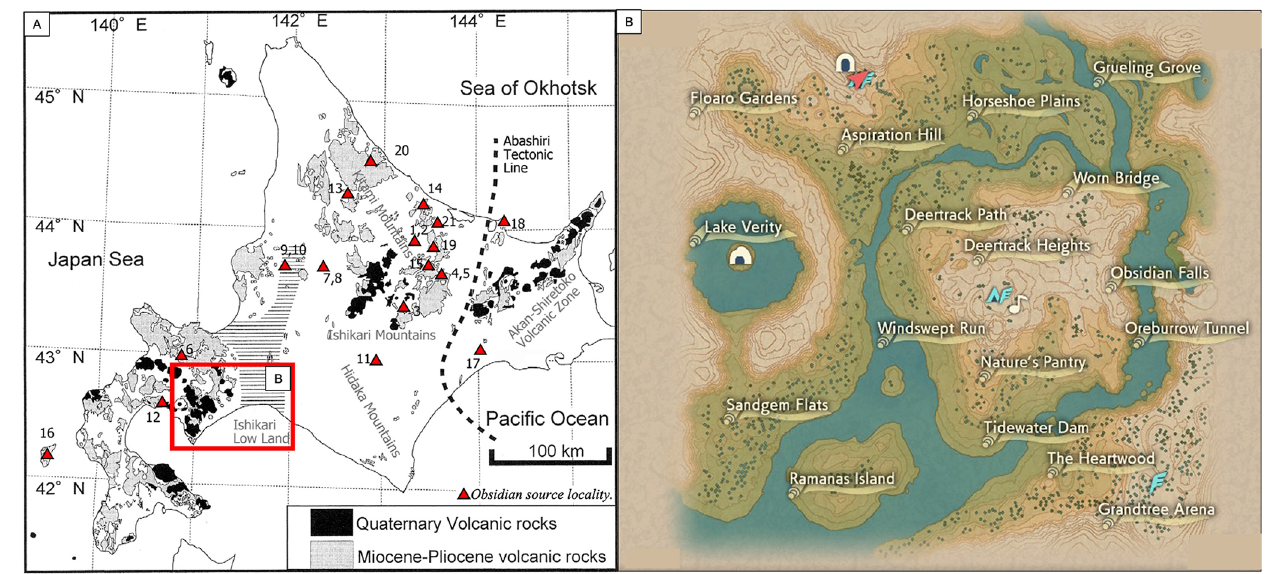
Figure 2. (a) Map of Hokkaido showing the source locations of all 21 recorded obsidian sites (red triangles) across the island (Izuho and Sato, 2007) and the location of the Ishikari Lowland that the Obsidian Fieldlands (red box) is based on in Pokémon Legends: Arceus . (b) A zoomed-in game map of the Obsidian Fieldlands (zoomed-out version in Fig. 1a) from Pokémon Legends: Arceus ©The Pokémon Company International